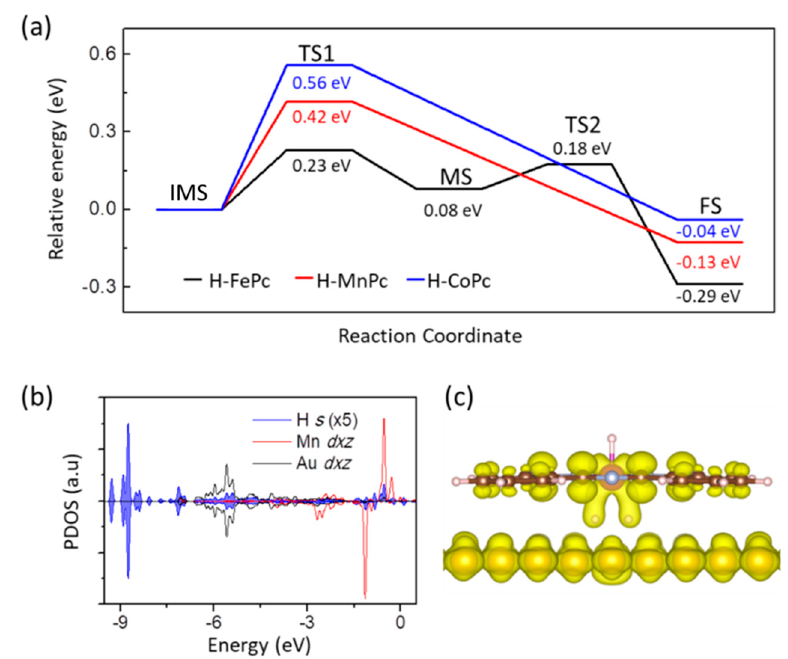
Figure 3. ( a ) Reaction pathway of hydrogen dissociation in H-TMPc / Au(111). ( b ) Projected density of states on hydrogen s , Mn d xz , and Au d xz in transition state. ( c ) Partial charge density from − 1.5 eV to Fermi level shown in ( b ). Legend: PDOS, projected density of state.